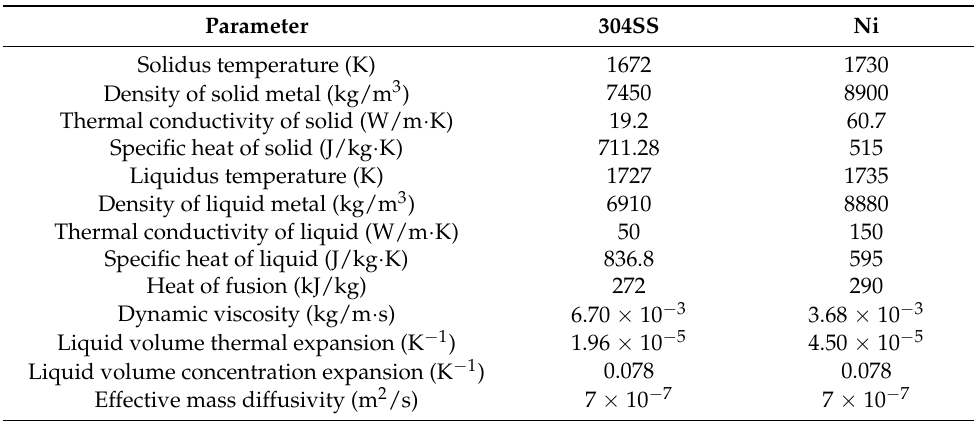
Table 2. Thermophysical properties of 304SS and Ni